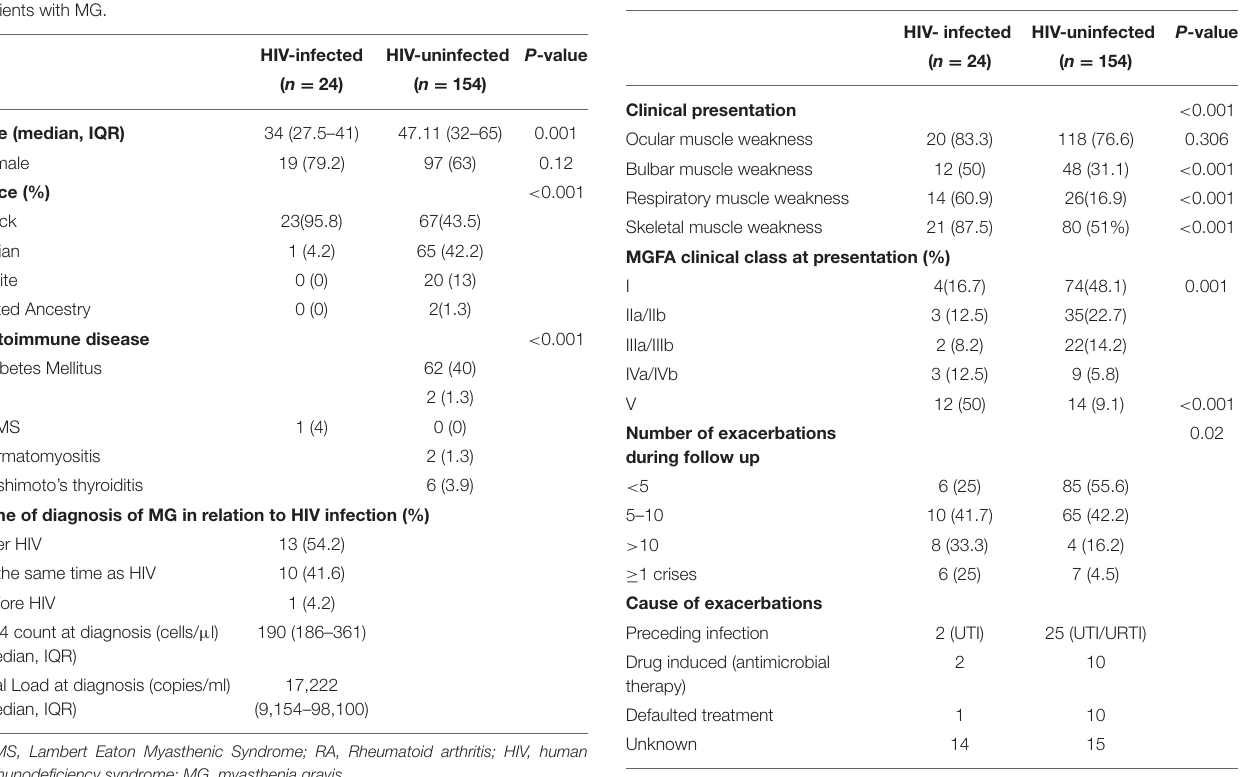
TABLE 2 | Clinical Profile of HIV-infected and HIV-uninfected patients with